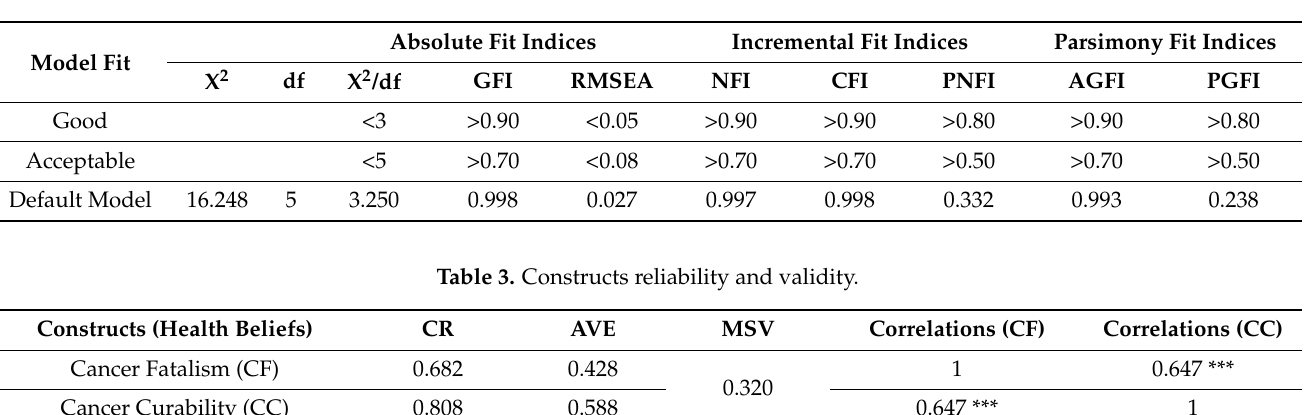
Table 2. Fit indices for measurement model of health beliefs.